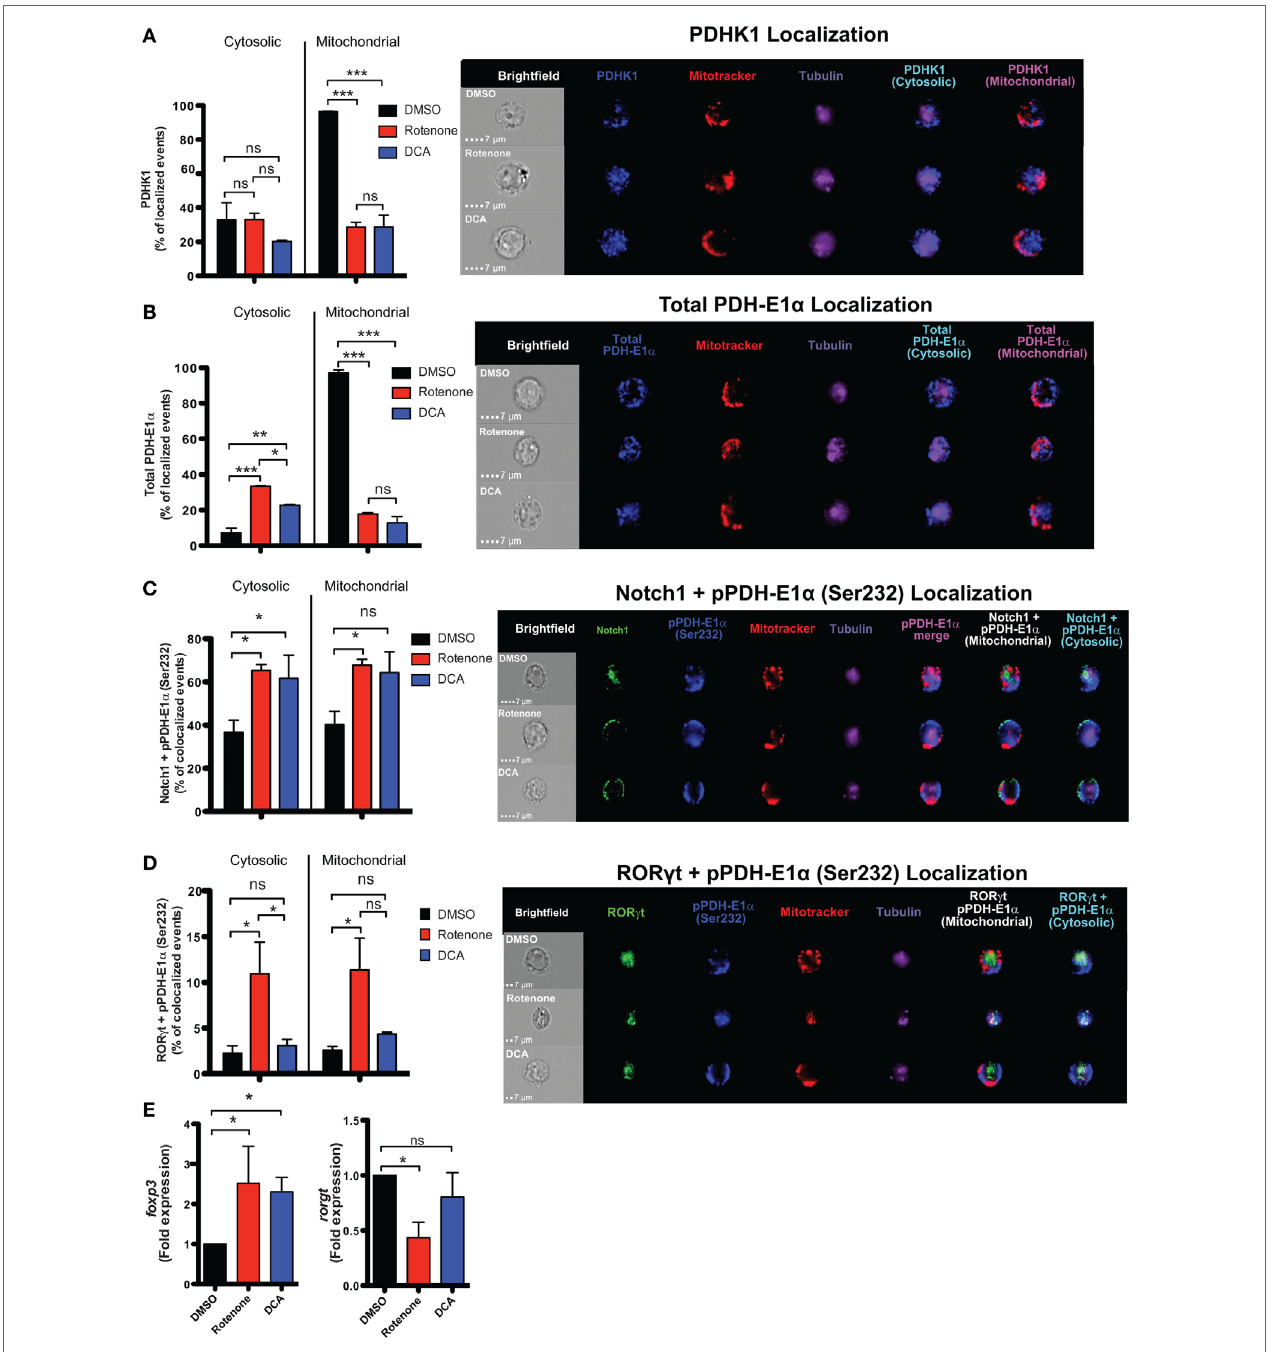
FigUre 6 | Rotenone treatment inhibits mitochondrial localization of pyruvate dehydrogenase kinase 1 (PDHK1) and promotes ROR γ t and Notch1 colocalization with its phosphorylated substrate, pPDH-E1 α , in Th17-polarized cells. CD4 T cells were treated either with 20 µM rotenone for 2 h or 1 mM dichloroacetate (DCA) (left in the cell suspension throughout) and then stimulated with plate-bound anti-CD3 ε plus anti-CD28 for 72 h in the presence of Th17 polarization conditions. After 72 h, samples were split and half of the cells were stained for PDHK1, total PDH-E1 α , pPDH-E1 α (Ser232), ROR γ t, and Notch1 to determine their localization in cytosol (Tubulin AF647 staining) and mitochondria (Mitotracker CMXRos). Data were acquired via AMNIS ImageStream X Mark Imaging Flow Cytometer. Quantification of percent of cytosolic or mitochondrial (a) PDHK1-localizing cells and (B) total PDH-E1 α -localizing cells along with corresponding representative images are shown. For colocalization, percent of (c) Notch1 + pPDH-E1 α (Ser232)-colocalizing and (D) ROR γ t + pPDH-E1 α (Ser232) Th17-polarized cells for each treatment condition and representative images are shown. Total RNA was collected from the other half of treated cells and qPCR was performed for measuring (e) foxp3 and rorgt expressions upon rotenone treatment (DCA treatment was used as a control which triggers foxp3 expression). Data represent the mean ± SEM of three independent experiments. * p < 0.05; ** p < 0.01, *** p < 0.001 calculated using an unpaired, two-tailed Student’s t